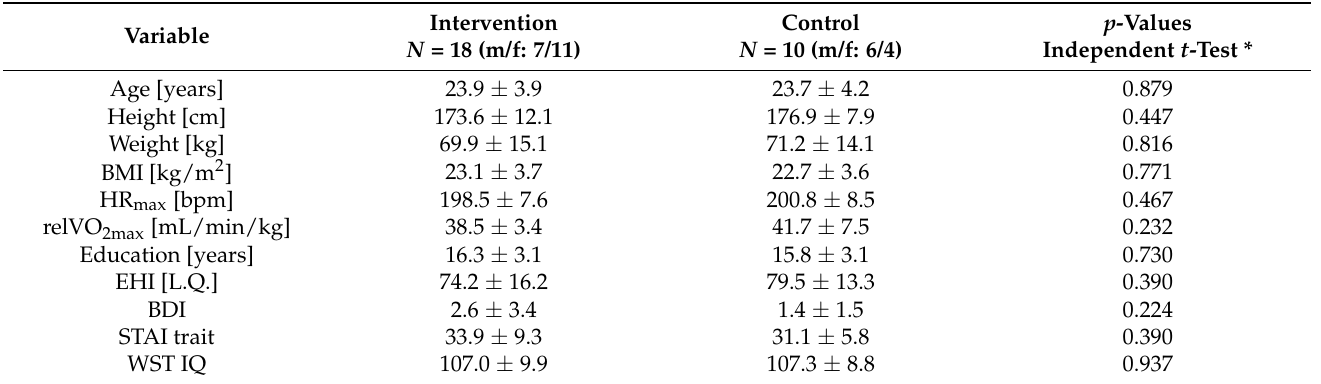
Table 1. Descriptive characteristics at